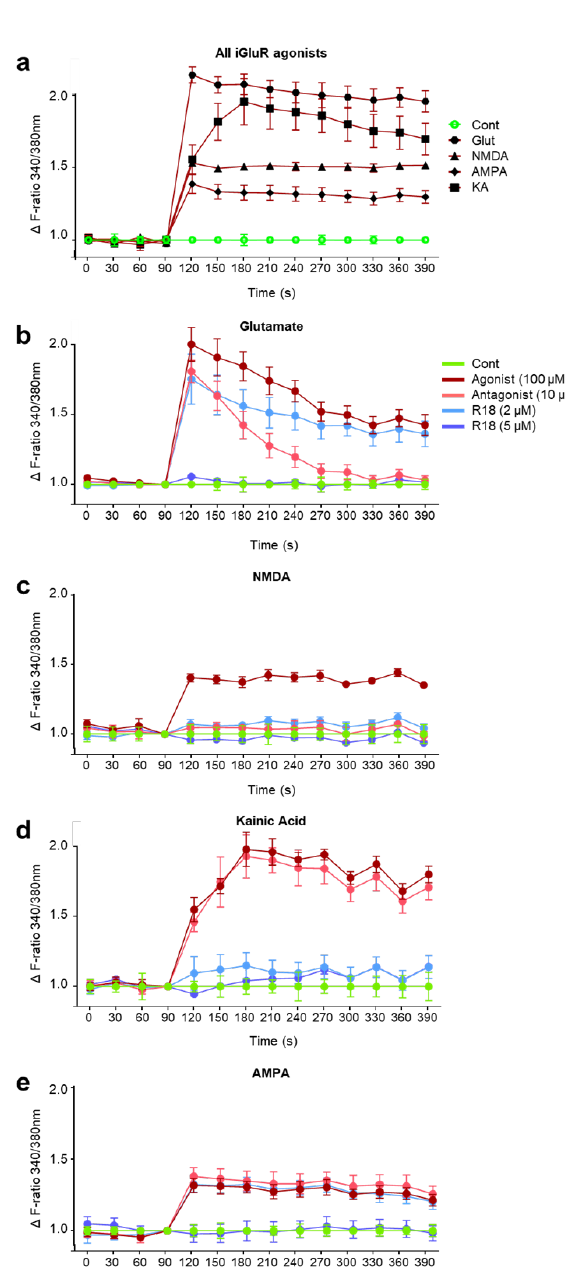
Figure3. R18 protects primary cortical neurons against iGluR-mediatedcalcium influx. Cortical neurons were loaded with Fura-2 AM (5 µ M in MEM / B27) for 30 min at 37 ◦ C, and the medium was replaced with 50 µ L phenol-free Hank’s Balanced Salt Solution (HBSS). Baseline calcium levels were measured every 30 s for 1.5 min prior to the addition of ( a ) iGluR agonists, glutamate, NMDA, AMPA, and KA (100 µ M final concentration). Subsequent calcium measurements were made every 30 s for 5 min. To assess the neuroprotective ability of R18 against receptor-mediated calcium influx, neurons were treated with R18 (2 and 5 µ M) or receptor blockers (MK801 and / or CNQX; 10 µ M) for 10 min prior to stimulation with individual iGluR agonists, ( b ) glutamate, ( c ) NMDA, ( d ) kainic acid, ( e ) or AMPA, and calcium levels were collected every 30 s for a further 5 min. Values are means ± SD; n = 3, with a minimum of four biological replicates per sample in each experiment; * p < 0.05. Experiments were conducted at least three times with independent neuronal cultures. Fluorescent readings were adjusted to remove background signal and displayed as ∆ F ratio (340 / 380 nm) relative to the untreated control at each